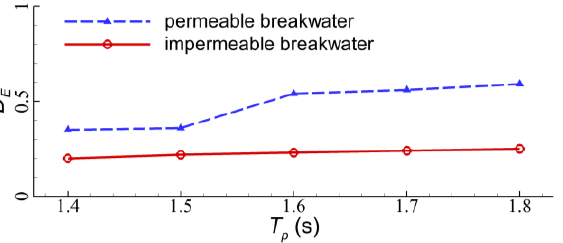
Figure 20. Variations in the total wave energy dissipation rate with the peak wave period.